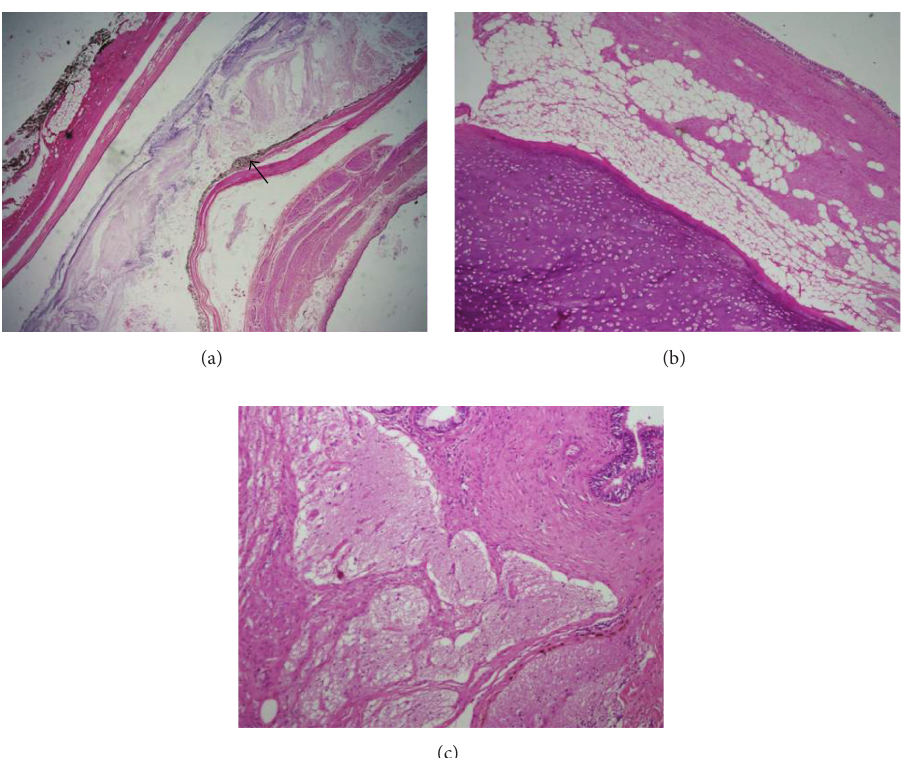
Figure 3: (a) Low power view showing choroid differentiation. Please note heavily pigmented melanocytes giving black coloration (arrow); H&E stain, 10x. (b) Respiratory lining with smooth muscle, adipose tissue, and mature hyaline cartilage; H&E stain, 10x. (c) Mature glial tissue with collagenous stroma. Focally mature glandular epithelium is noted. H&E, 20x.